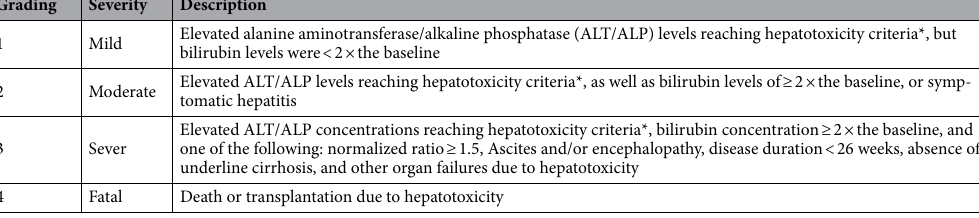
Table 2. The drug induced liver injury index 29 . *Criteria for hepatotoxicity are defined in the preceding